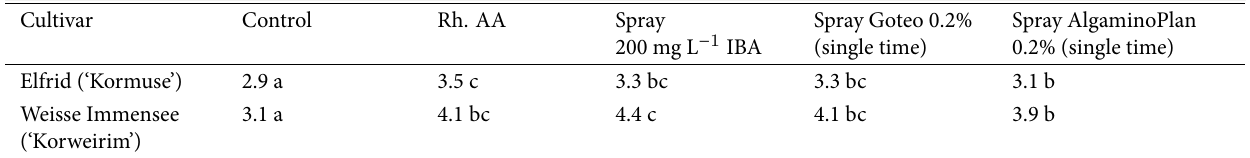
Table 3 The effect of IB, Goteo, and AlgaminoPlant on the degree of rooting in cuttings of Rosa Elfrid (‘Kormuse’) and Weisse Immensee (‘Korweirim’).